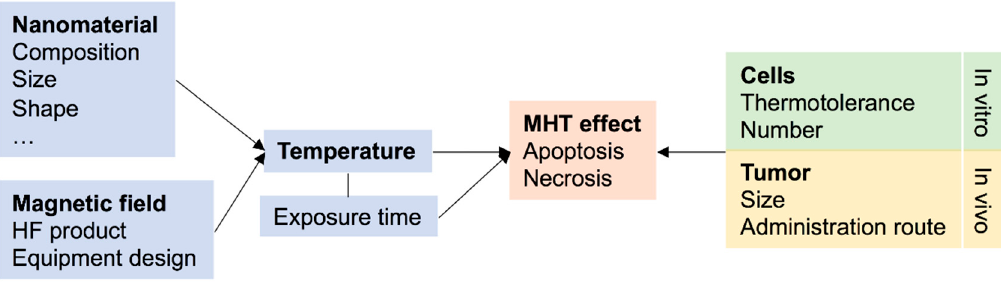
Figure 4. Main parameters contributing for the magnetic hyperthermia (MHT) effect in in vitro and in vivo scenarios.